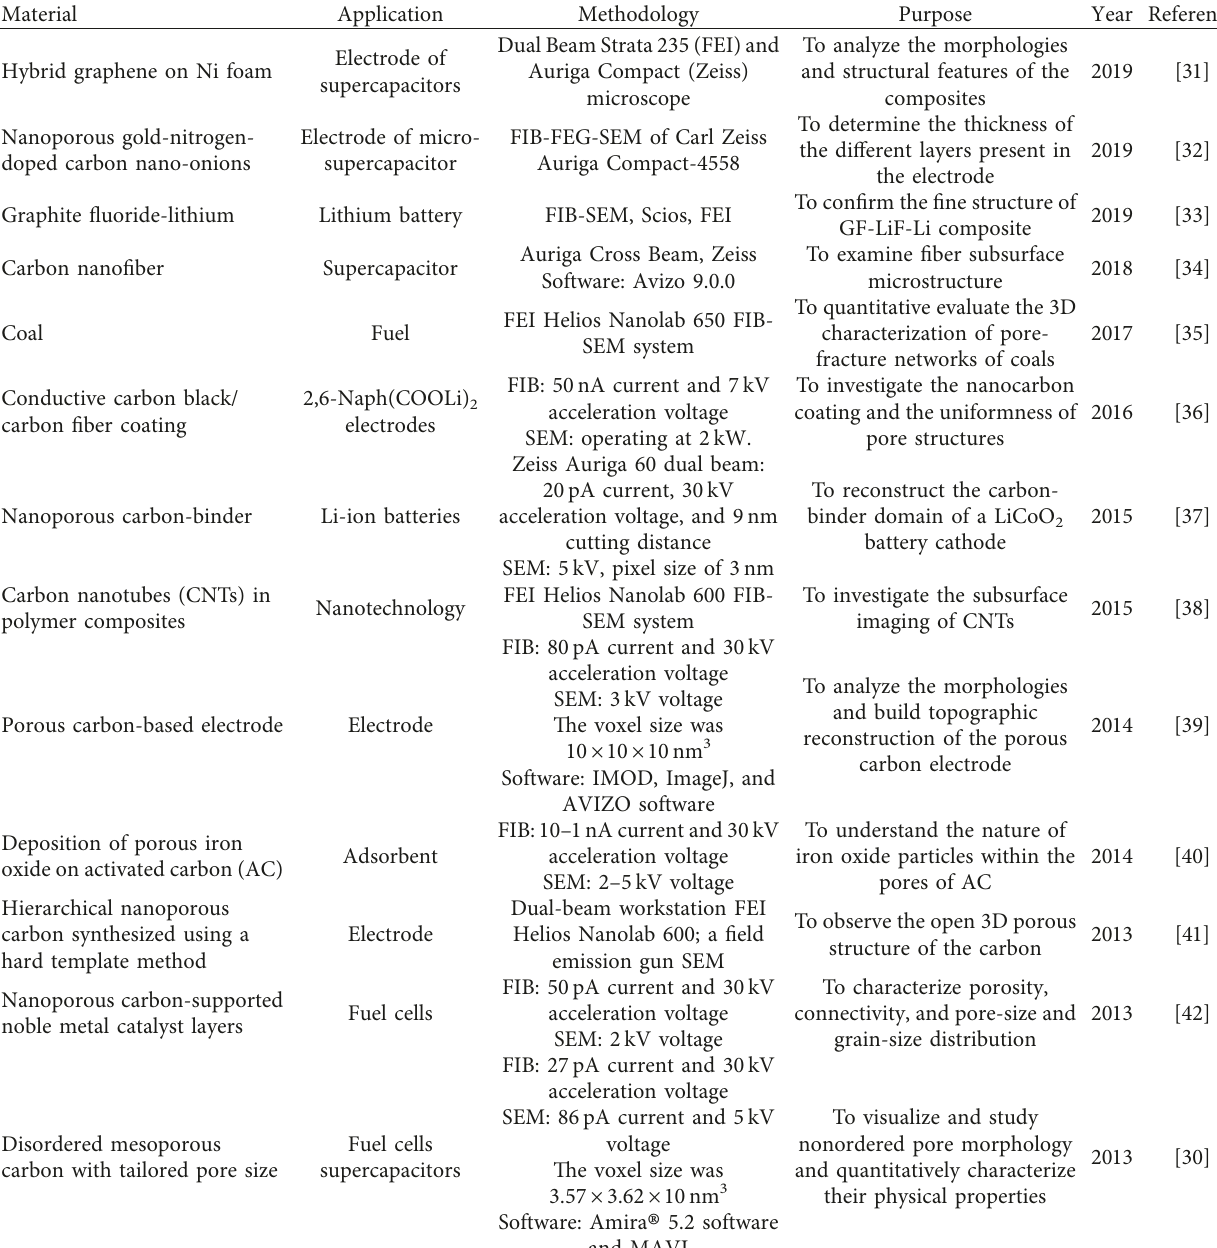
Figure 2: The procedures of FIB-SEM 3D reconstruction. (a) Stack of images produced with FIB-SEM, (b) imaging 3D reconstruction, and (c) quantitative 3D reconstruction and modeling [30]. Table 1: Short indicative selection of FIB-SEM for carbon-based materials from the